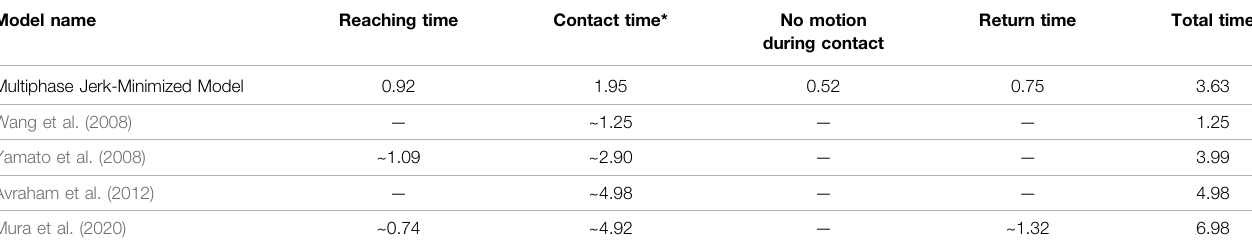
TABLE 11 | Comparisons between the Handshake phase Durations of the multiphase Jerk-Minimized Model and Earlier Models (in